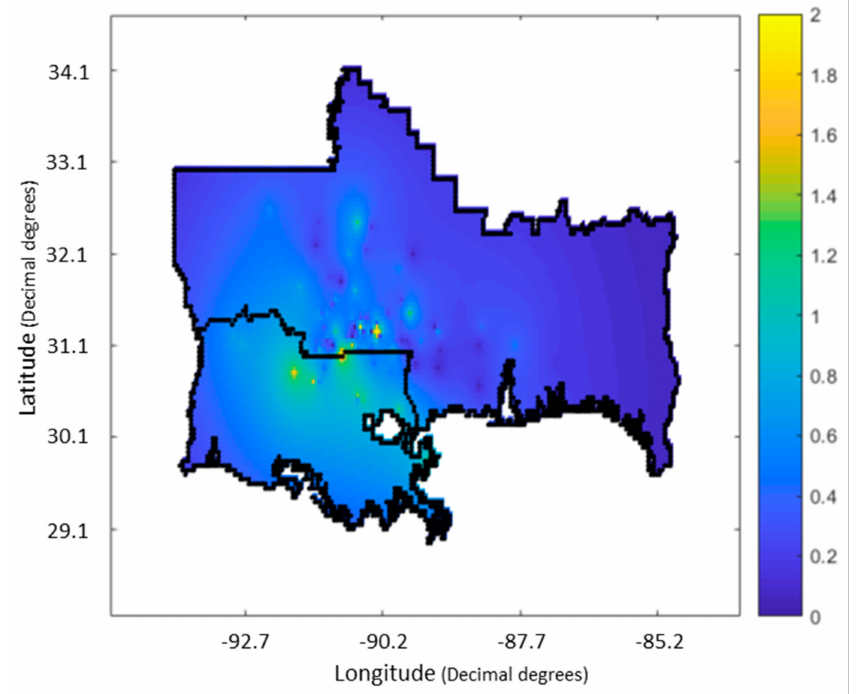
Figure 8. Spatial distribution of the 5% percentile TOC wt% values of the cumulative distribution function at each estimation